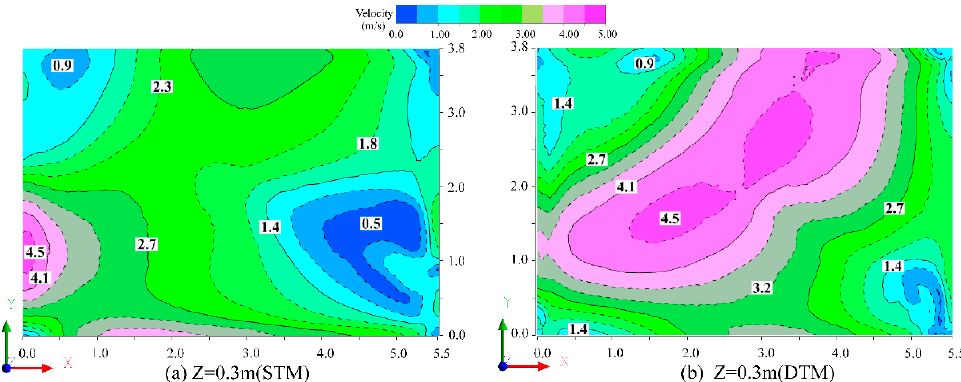
Figure 10. Velocity cloud map under dynamic and static conditions of Z = 0.3 m section.